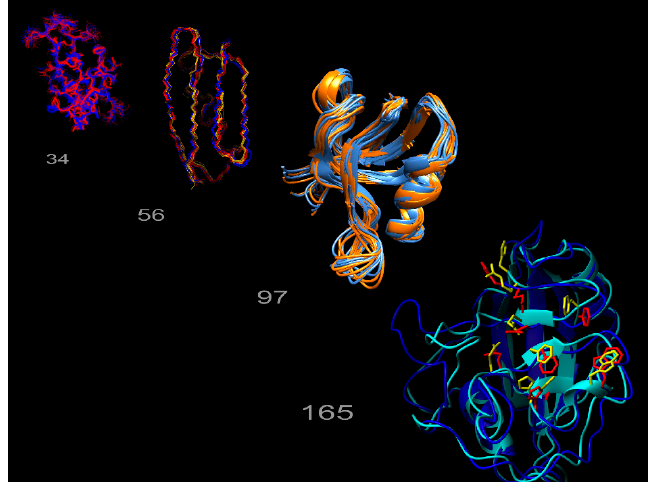
Figure 1. Exact nuclear Overhauser enhancement (eNOE) structure gallery. The multi-state ensembles calculated from eNOEs for the WW domain of Pin1 (34 residues), the third domain of immunoglobulin binding protein G (GB3; 56 residues), the second post-synaptic density-95/discs large/zonula occludens-1 (PDZ2) domain from human tyrosine phosphatase 1E (97 residues), and human cyclophilin A (165 residues), are shown from left to right.